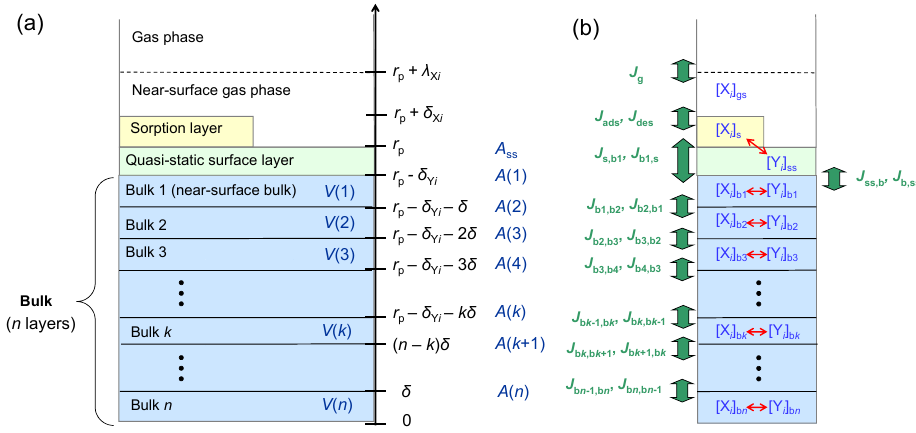
Fig. 1. Kinetic multi-layer model (KM-SUB): (a) Model compartments and layers with corresponding distances from particle center ( r p ± x) , surface areas ( A) and volumes ( V ) ; λ X is the mean free path of X i in the gas phase; δ X i quasi-static bulk layers; δ is the bulk layer thickness. (b) Transport fluxes (green arrows) and chemical reactions (red